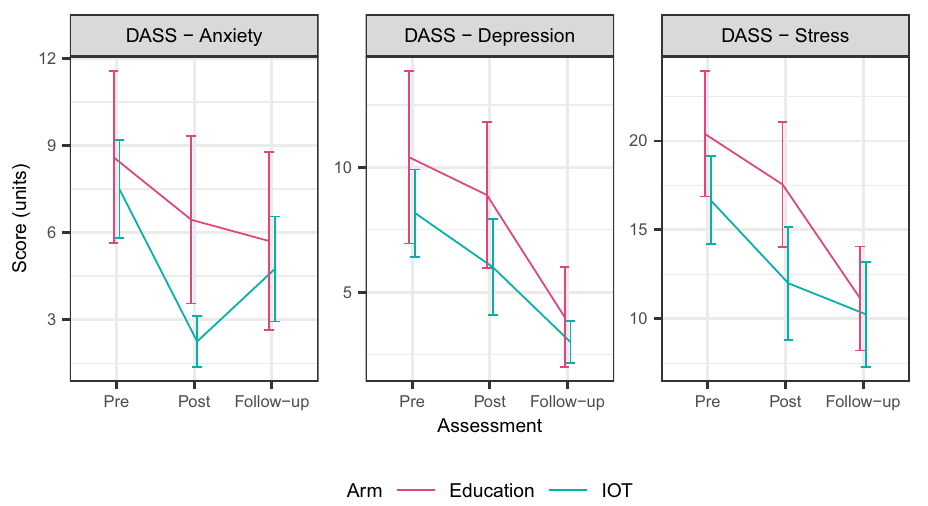
Figure 3. Adjusted mean difference in measures of emotional wellbeing following